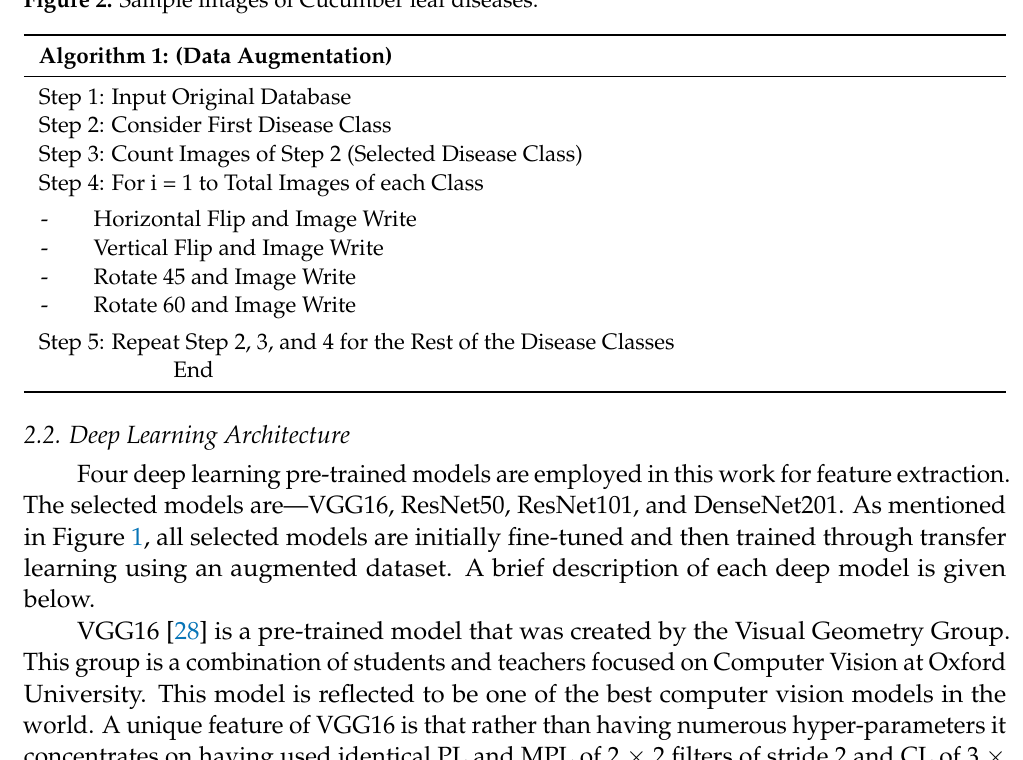
Figure 2. Sample images of Cucumber leaf diseases.